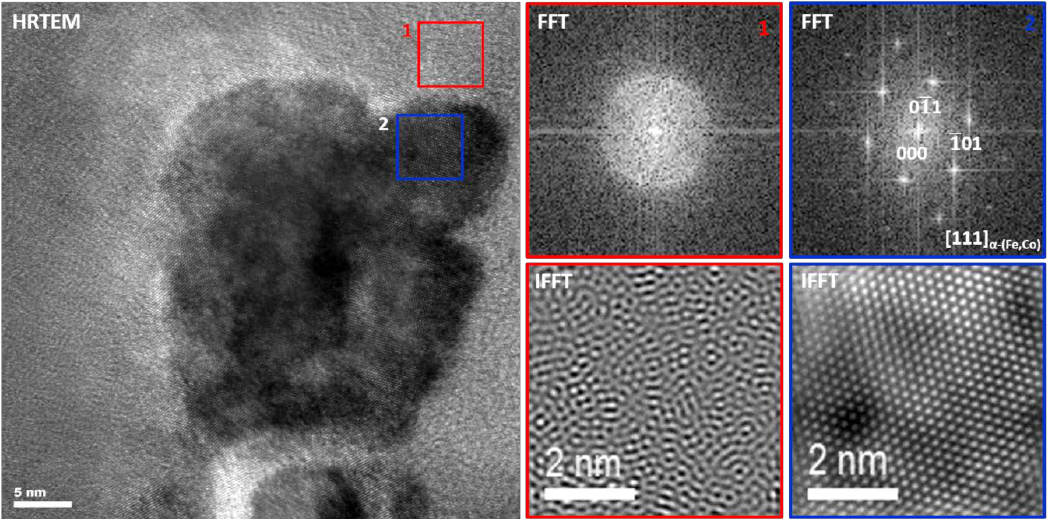
Figure 10. HRTEM image, FFT, and IFFT images taken from the (1) amorphous region and (2) α - (Fe,Co) crystallite for Fe 67 Co 20 B 13 heat-treated at 485 °C/2 s.